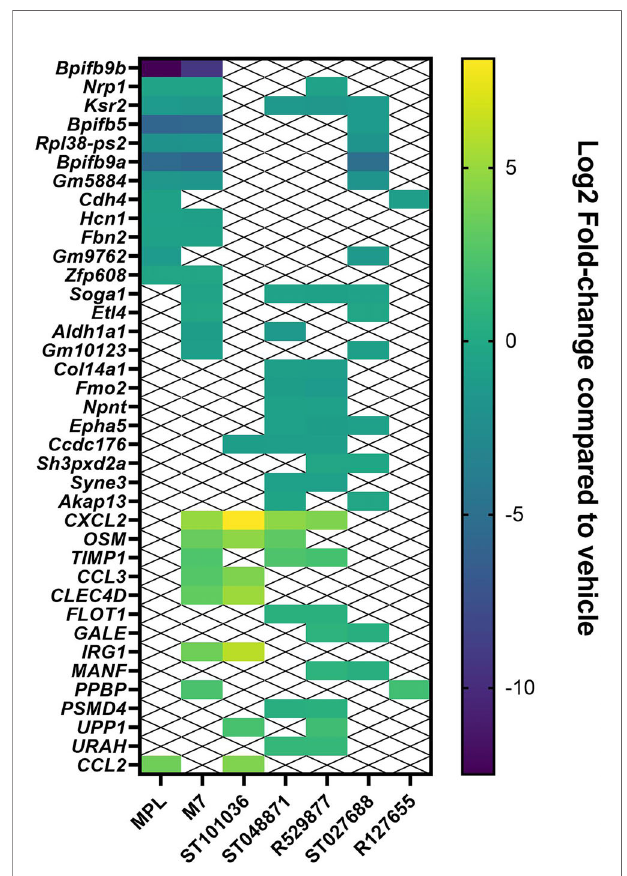
FIGURE 4 | Small molecule mast cell activators modify gene expression in the NALT after nasal delivery. Lead small molecule mast cell activators, M7 and MPL were nasally administered to C57BL/6 mice (n = 5 mice per group). NALT cells were harvested from each mouse six hours after compound delivery and processed for RNA sequencing. Genes enhanced or inhibited by more than one compound were compared amongst vaccine adjuvants. The Log2 fold-change over vehicle control for each gene is